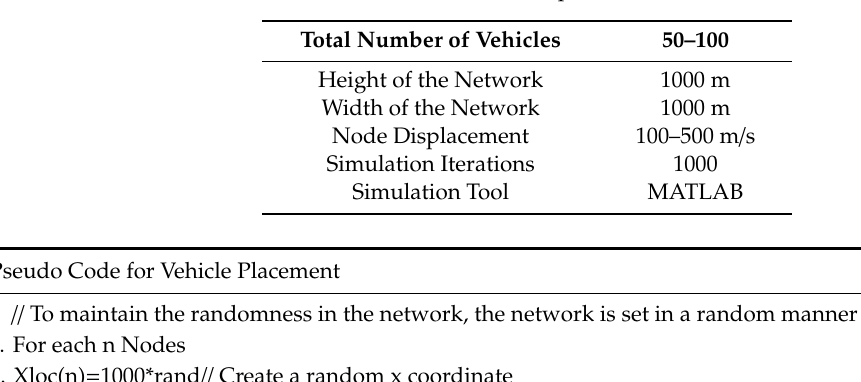
Table 2. Network